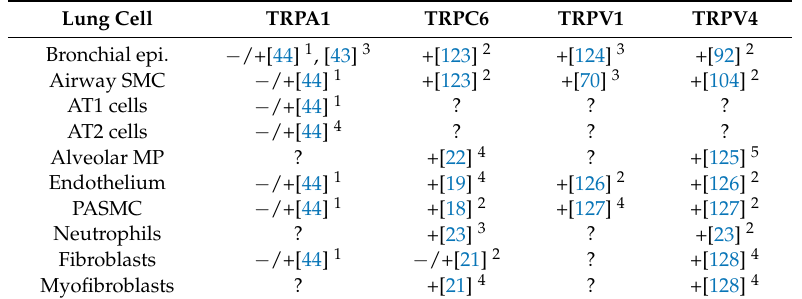
Table 5. TRP expression patterns in lung